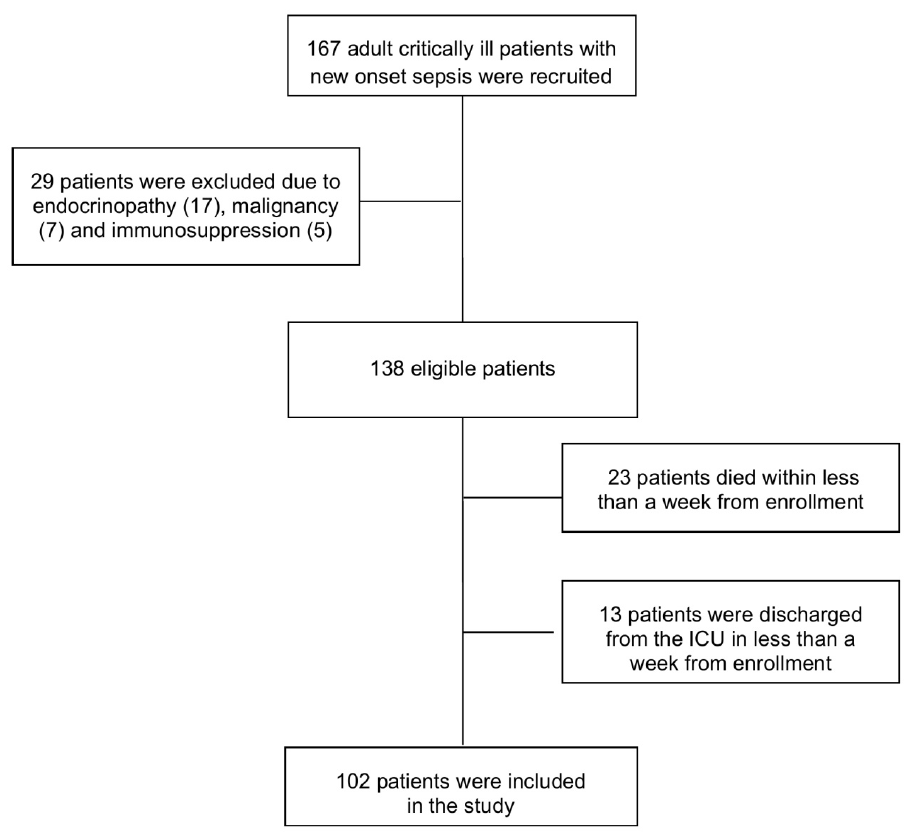
Figure 1. Flowchart of the study population.